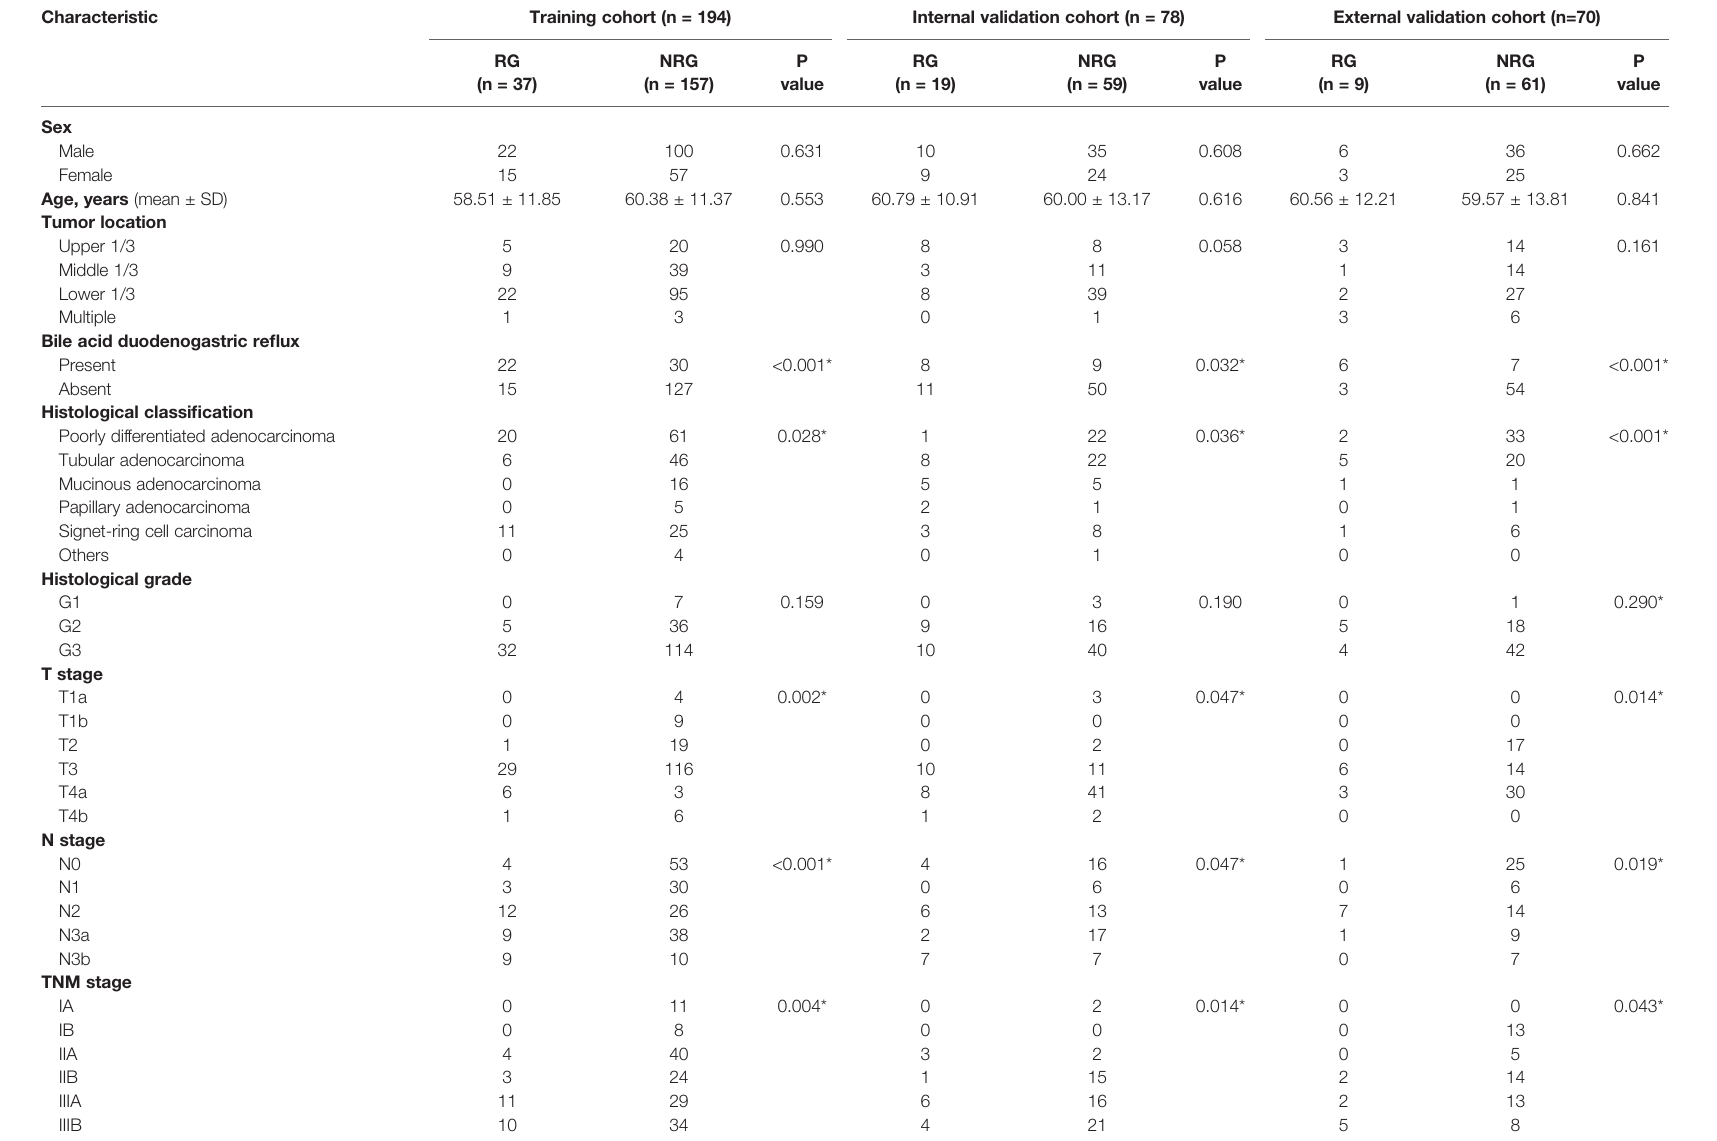
TABLE 1 | Clinicopathological characteristics of the RG and the NRG in the training and validation cohorts.